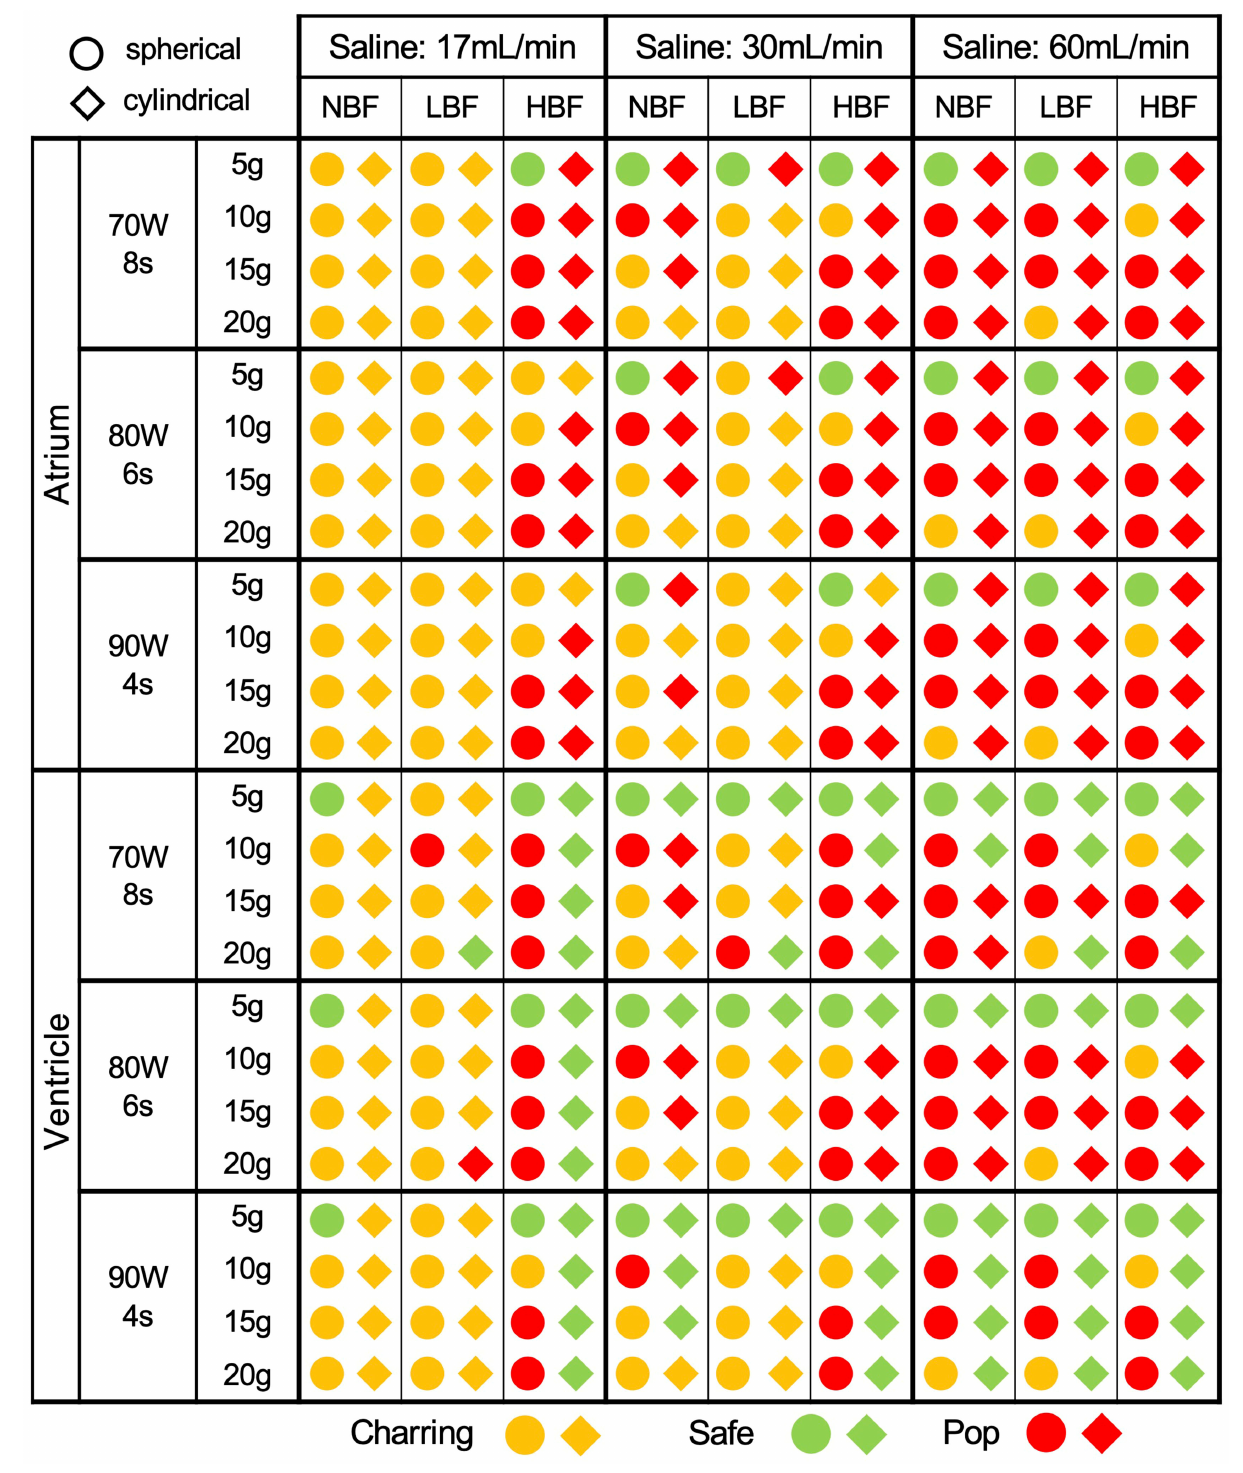
Frontiers in Medical Technology |